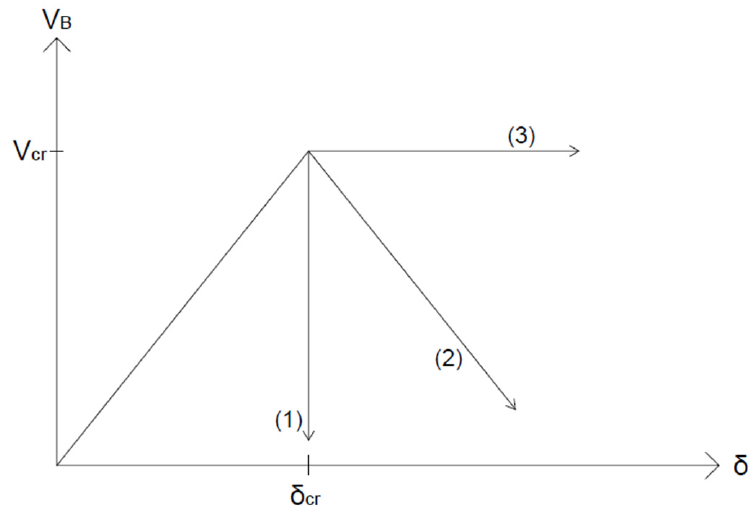
Figure 3. Possible post-critical behavior of the compressed diagonal.